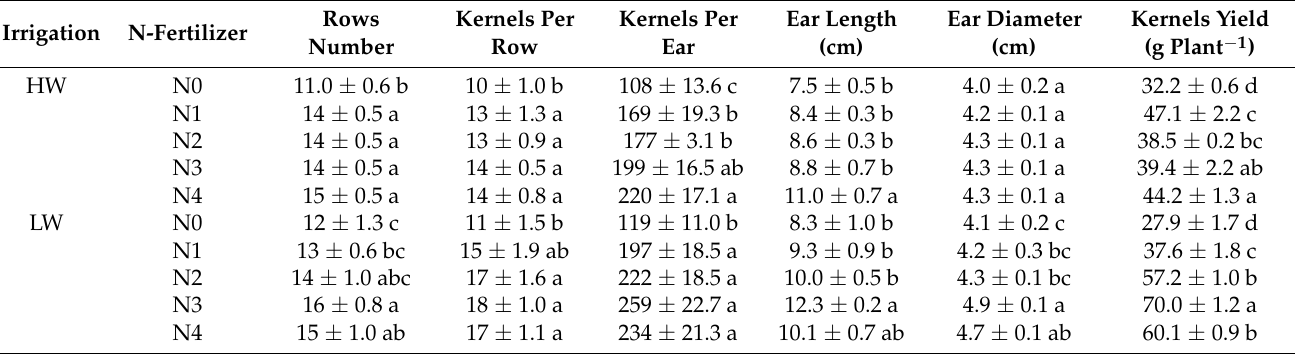
Table 1. Effect of different water and N treatments on yield and yield components of maize.